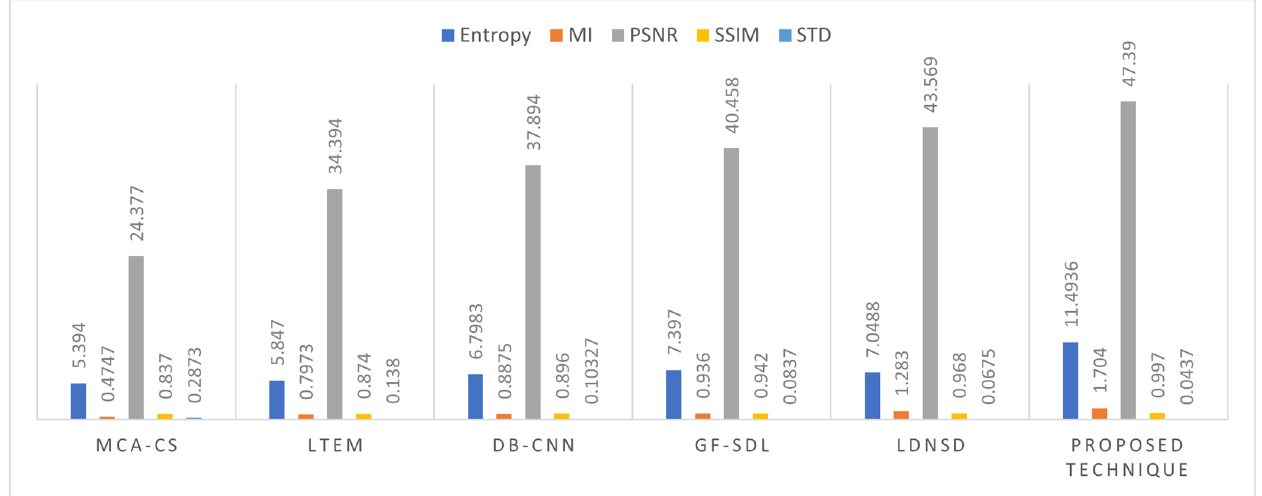
Figure 8. Percentage-based visual display of MR-CT image fusion methods (MCA-CS [14], LTEM